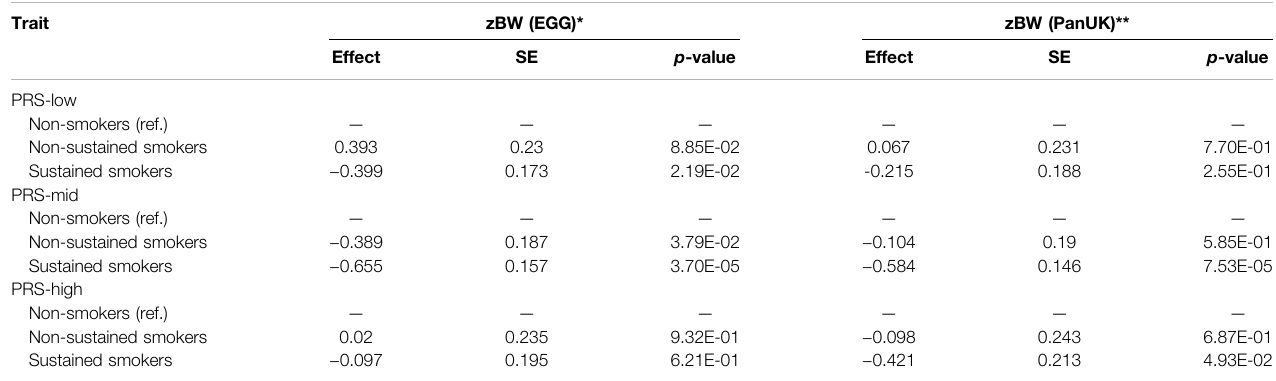
Models were adjusted for the fi rst 10 GWAS PCS and maternal education. Sample sizes are N = 275 for PRS-low, N = 539 for PRS-mid, and N = 266 for PRS-high. *The PRS used in the models was calculated using the base GWAS from the EGG consortium.